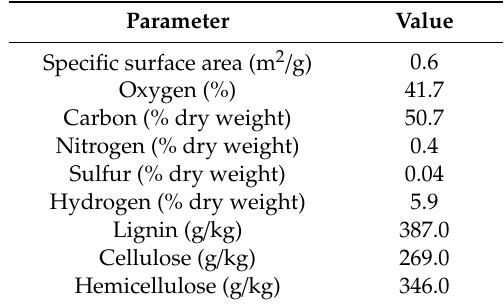
Table 1. Physicochemical properties of olive stone.